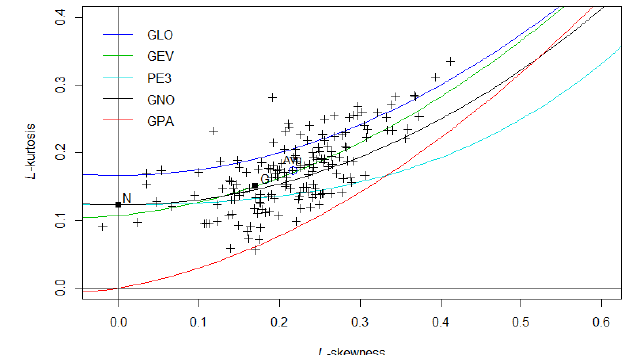
Figure 2. L-moment ratio diagram indicating the average value of L-moment ratios of 1-day AM rainfall series fall on the theoretical line of the GEV